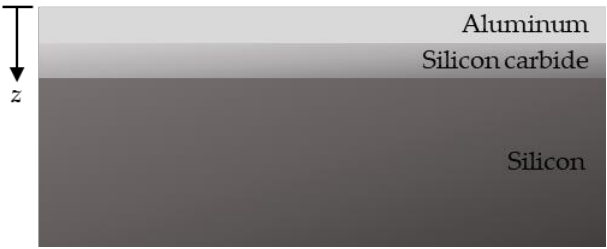
Figure 2. The coordinate system. The silicon substrate is a semi-infinite